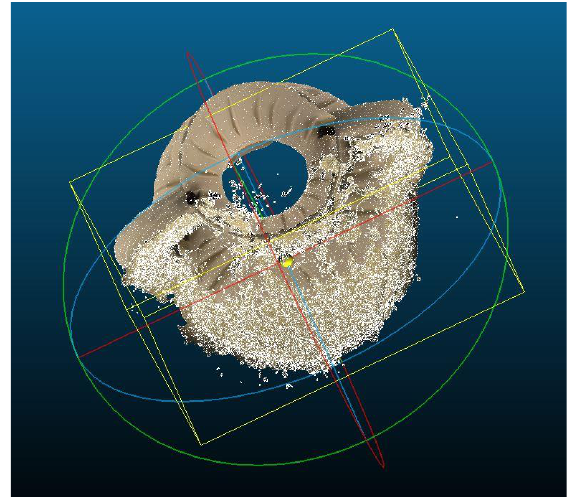
Figure 11. The stage of combining the reconstructed front model with respect to the object model (textured model).